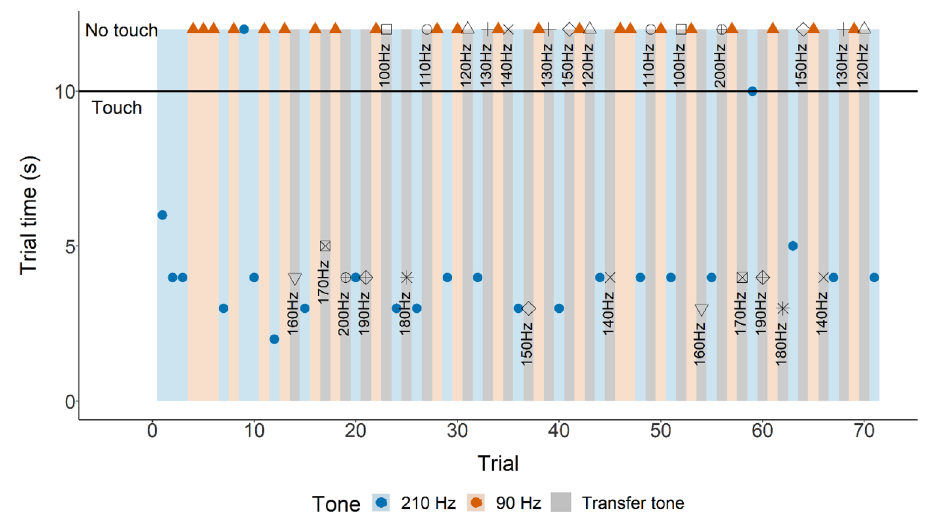
Figure 9. Supersession 10 (shark 1). Touching the loudspeaker indicated by the time it took to touch (LST time). Not touching the loudspeaker indicated by the shapes (at 12 s, indicating a capped trial i.e., the loudspeaker was not touched) above the horizontal solid black line (indicating the maximum trial time). Background colour indicates each separate phase (‘Go’ phase: blue, ‘No-Go’ phase: ‘orange, transfer: